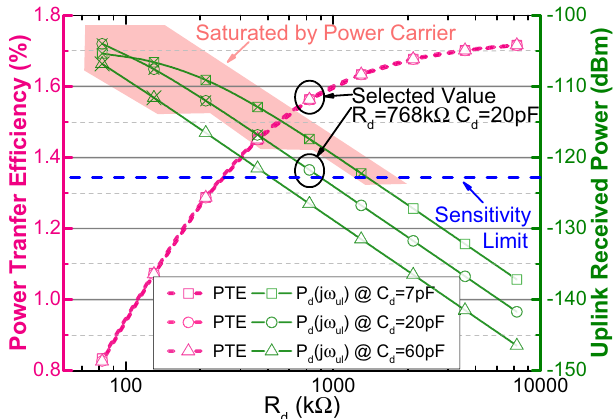
Figure 6. Calculated PTE and the received uplink signal power at V d versus R d and C d , when k =